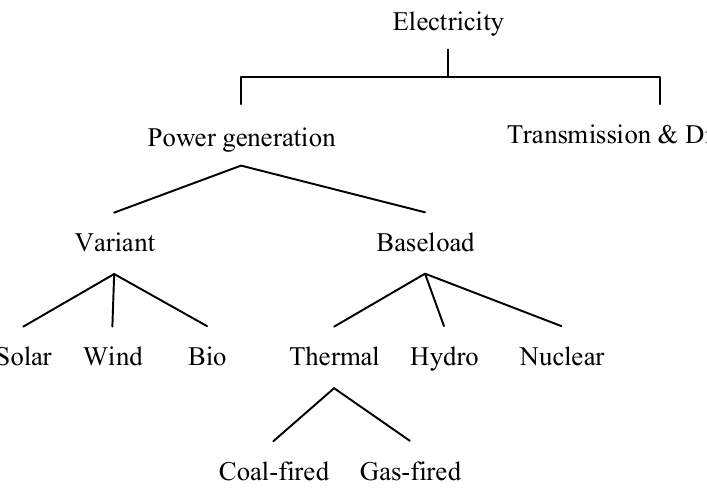
Figure 4. The nesting structure of electric powers used by producing sectors.